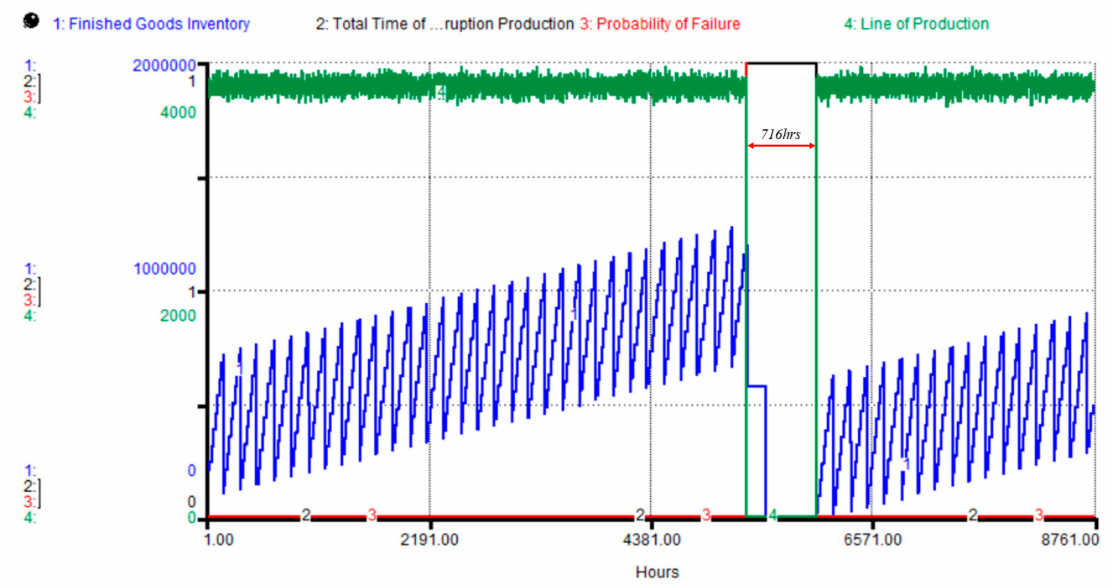
Figure 4. Time of disruption in line of production without spare parts in inventory.